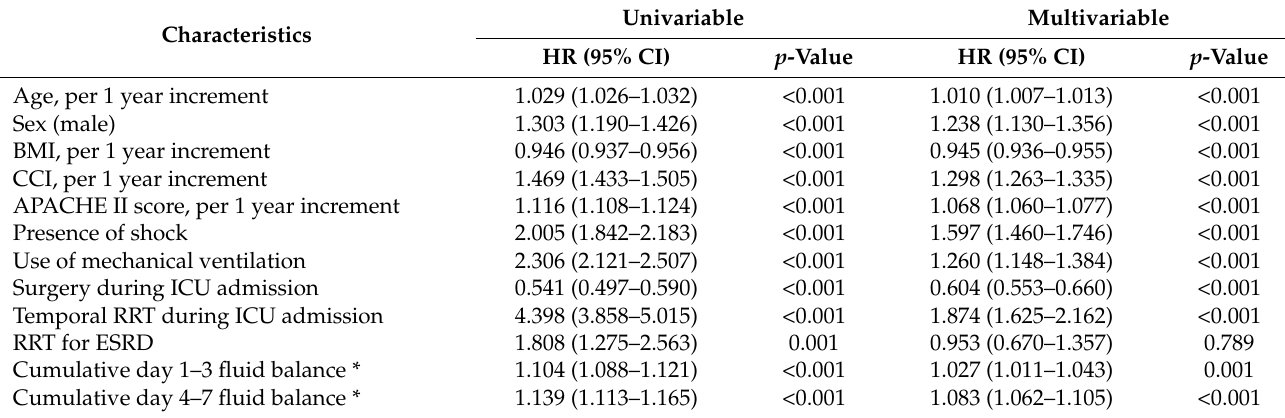
Figure 2. Impact of day 1–3 ( A , B ) and day 4–7 ( C , D ) fluid balance on long-term mortality among 6978 surgically ill patients with and without shock (Shock: ( A , C ); non-shock: ( B , D )). Table 3. Cox proportional hazard regression analysis for mortality.